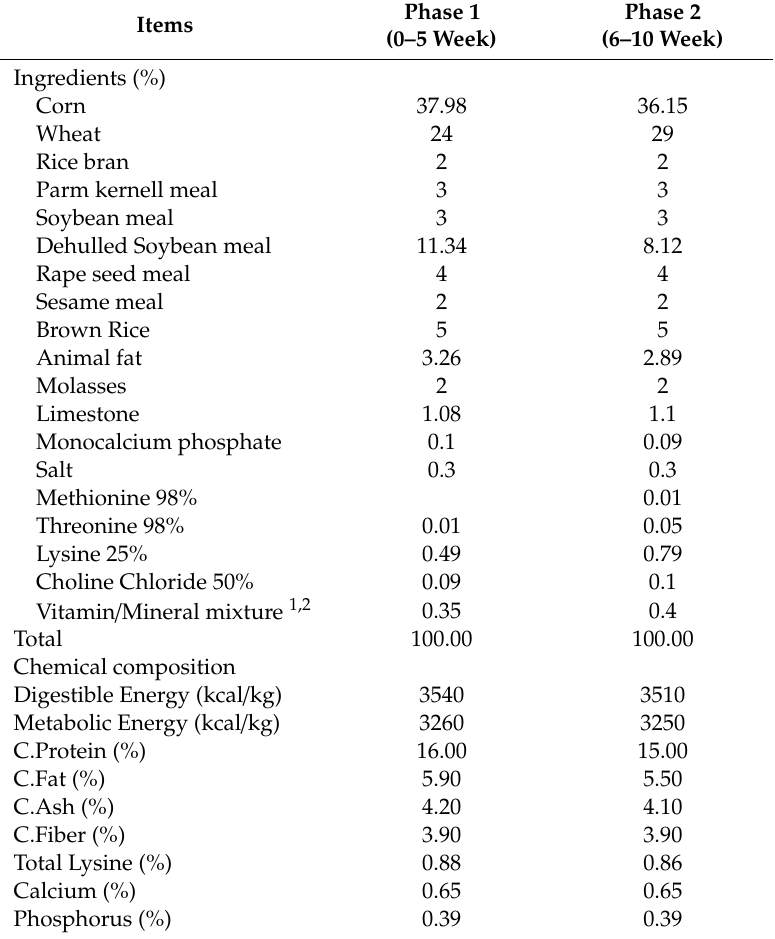
Table 1. Composition of finishing pig diets (as